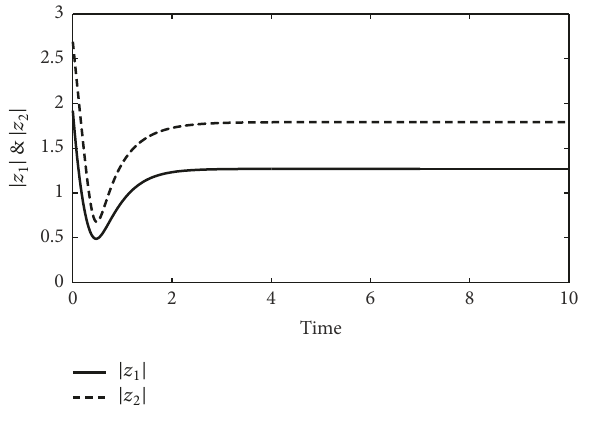
Figure 6: State curves of |𝑧 1 | and |𝑧 2 |